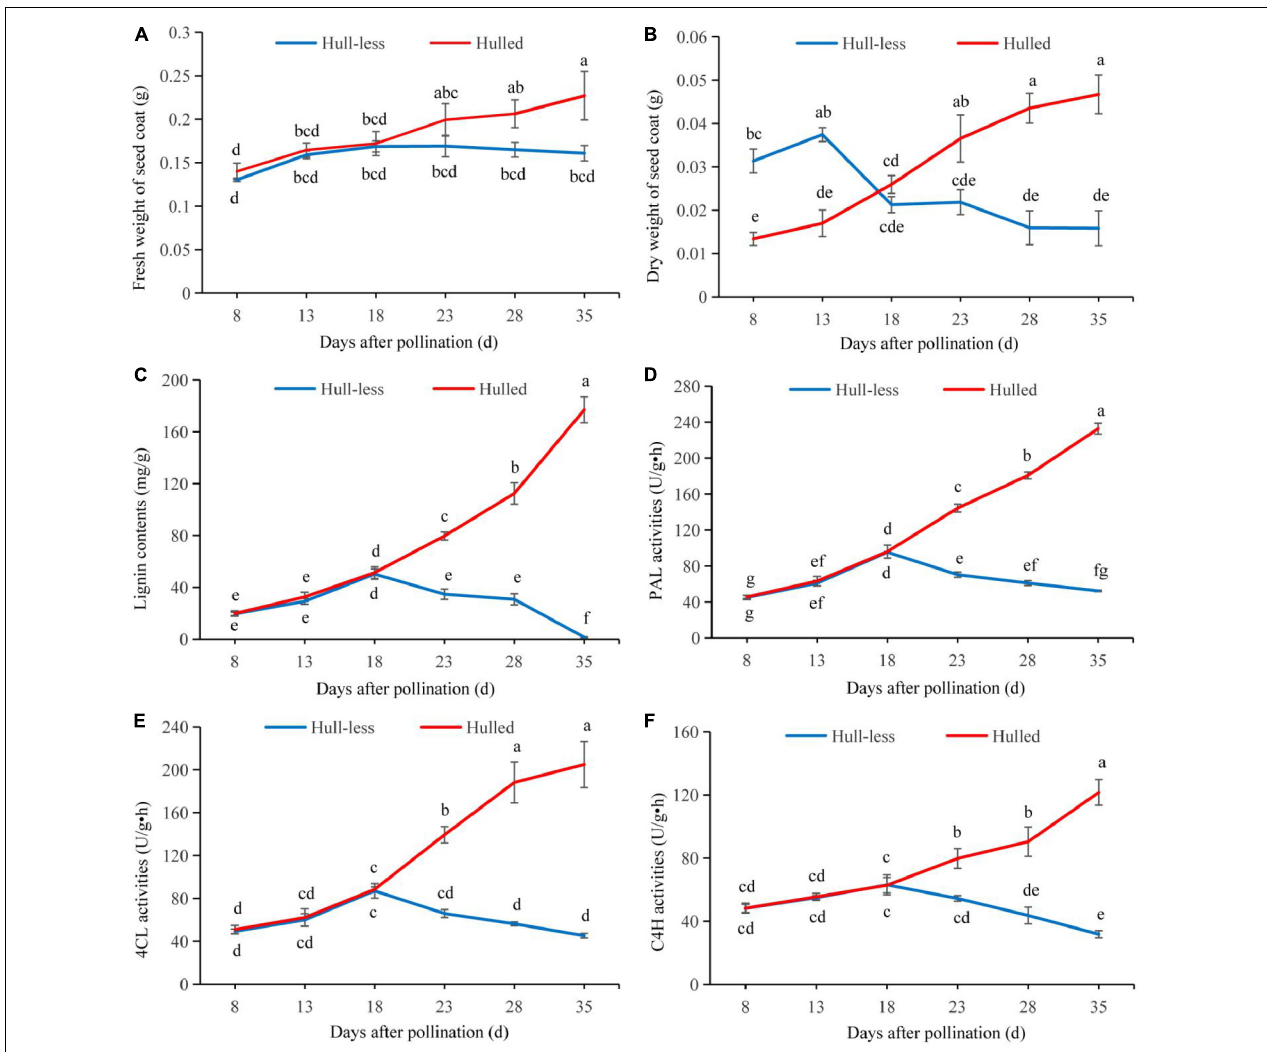
FIGURE 1 | Activities of related enzymes in the seed coat of C. pepo , from 8 to 35 days post-pollination (red represents the hulled varieties, while blue represents the hull-less varieties). (A) Fresh weight of the seed coat. (B) Dry weight of the seed coat. (C) Lignin content in the seed coat. (D) PAL enzyme activity in the seed coat. (E) 4CL enzyme activity in the seed coat. (F) C 4 H enzyme activity in the seed coat. For each treatment, the bar represents mean ± SE of three replicates. The different lower case letters represent significant differences at P < 0.05